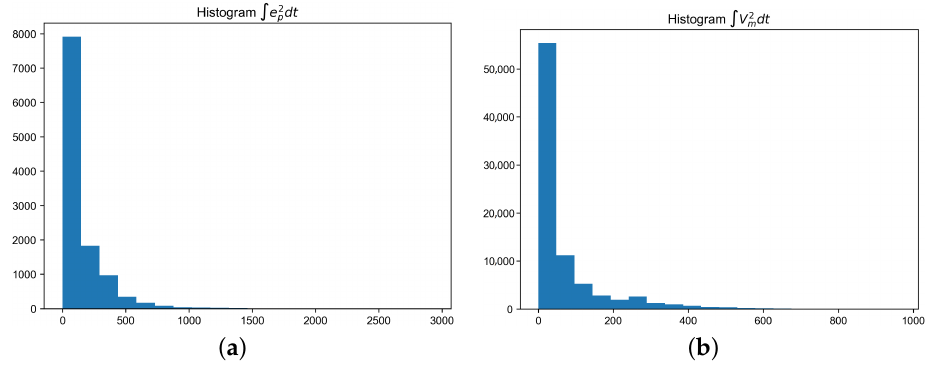
(cid:82) (cid:82) e 2 p dt , ( b ) V 2 m dt .